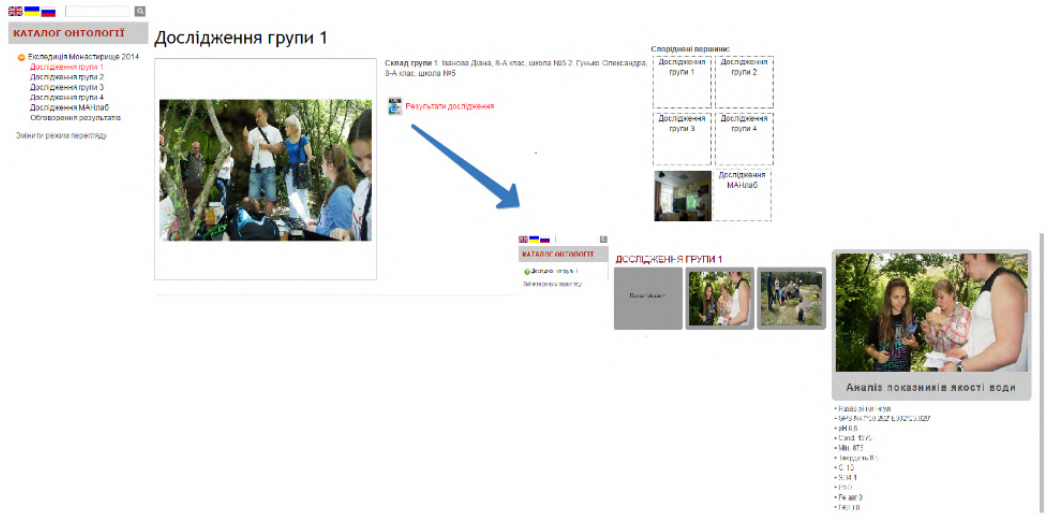
Figure 6: Visualization of scientific data in the ontological